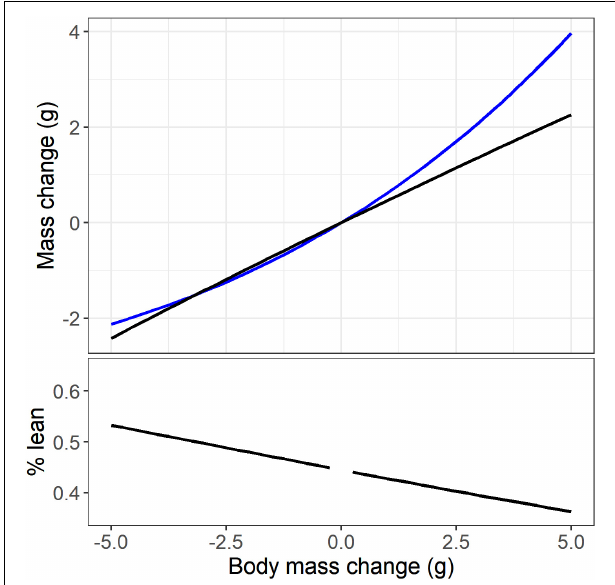
FIGURE 5 | The interaction between the predicted hyperallometry of fat mass change (blue line) and the predicted hypoallometry of lean mass change (black line) relative to body mass change for a White-throated Sparrow of median body mass. The % change of total mass that is lean mass is shown in the bottom panel. The observed range of body mass for White-throated Sparrow was 12.3 g.